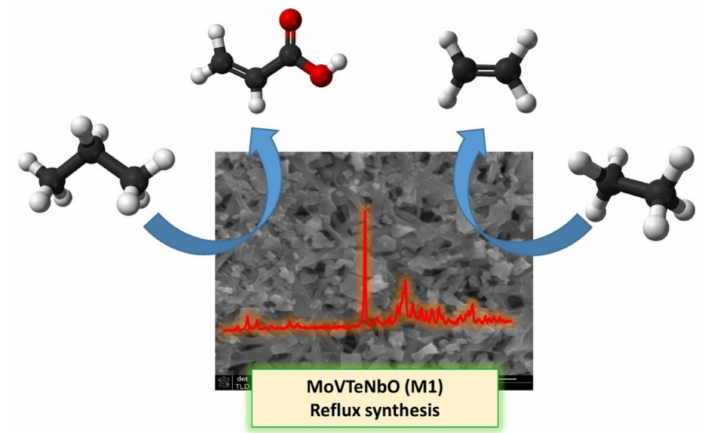
Figure 19. Reflux synthesis of the M1 catalyst for the selective oxidation of light alkanes. Adapted from ref. [122], Copyright (2020), with permission from Elsevier.